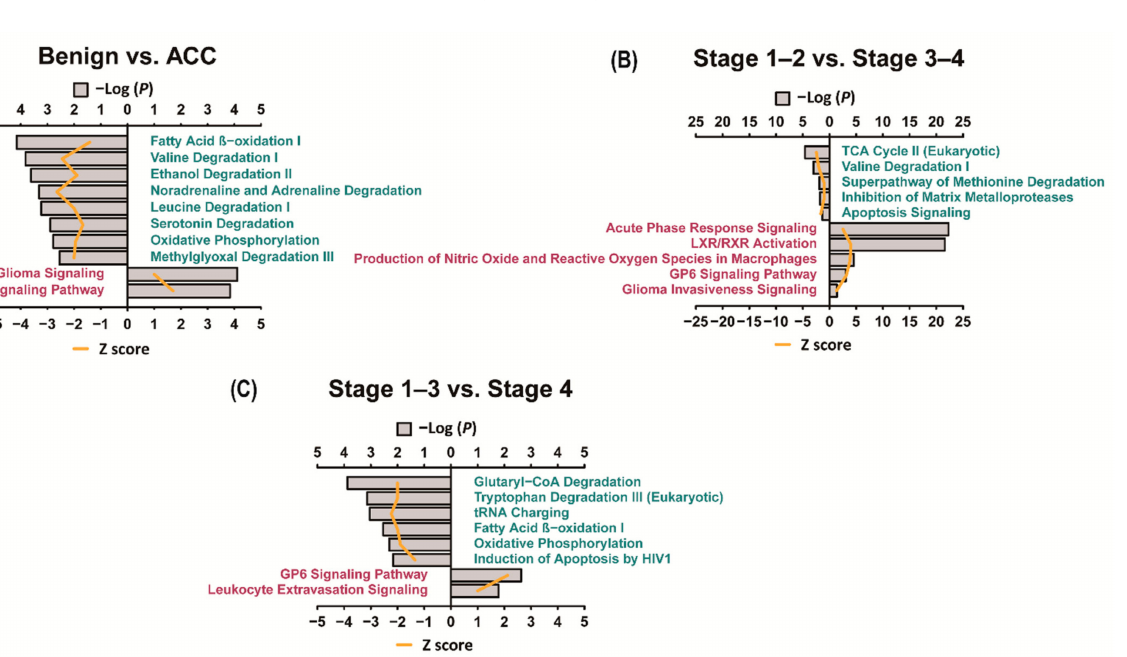
Figure 4. IPA analyses of the differential expression of proteins (Canonical pathway). IPA analysis was performed in the differentially expressed proteins identified in each group, and canonical pathways with low p -values were presented. ( A ) Pathways identified in benign adrenal adenomas are indicated in green, while pathways identified in ACC are indicated in red; ( B ) Pathways identified in stages 1–2 ACC are indicated in green, while pathways identified in stages 3–4 are indicated in red; ( C ) Pathways identified in stages 1–3 are indicated in green, while pathways identified in stage 4 are indicated in red. The Z-score indicates that the level of protein expression was significantly high, and it was significant when the absolute value was more than 1. ACC—adrenal cortical carcinoma; GP6—Glycoprotein VI; IPA—ingenuity pathway analysis; LXR/RXR—Liver X Receptor-Retinoid X Receptor; TCA—tricarboxylic acid